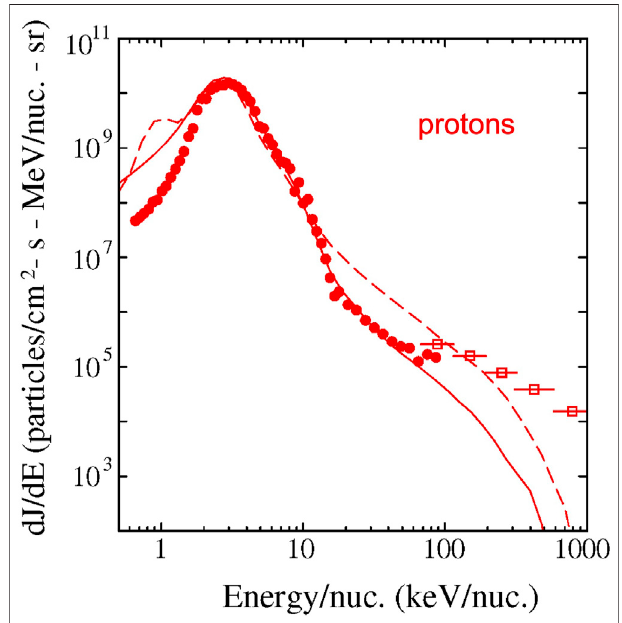
FIGURE 4 | Energy spectra at two regions downstream of the shock in thehybridsimulation shownin Figure2 (solidcurve1300 < x ω pi / c < 1500and 6300 < z ω pi / c < 7400) and (dashed curve 1100 < x ω pi / c < 1300 and 6300 < z ω pi / c < 7400). Observed downstream spectrum on DOY 118, 2001 by Lario et al. (2019) is also plotted for